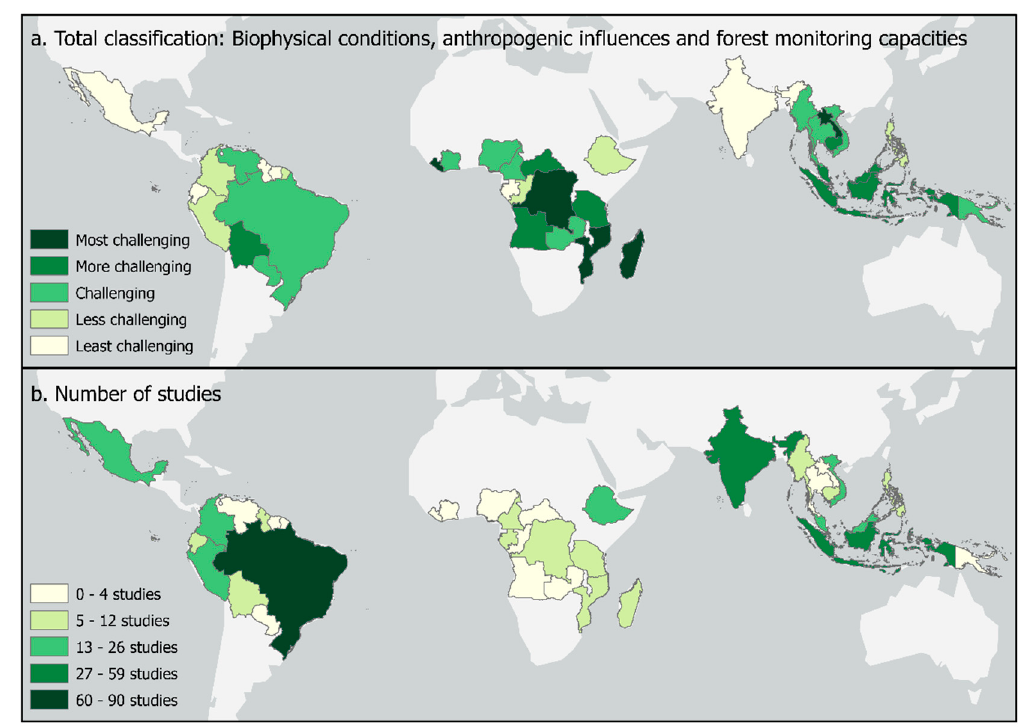
Figure 6. Comparison of the final classification of the countries (biophysical conditions, anthropogenic influences, and forest monitoring capacities) and the location of the studies performed in small area coverage.